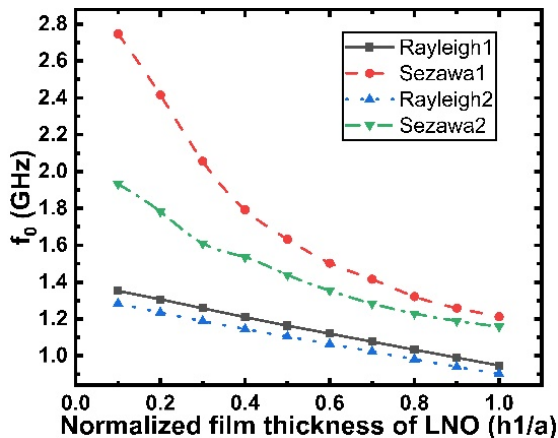
Figure 15. Plot of central frequency versus normalized LiNbO 3 thickness ( h 1 / a ). Rayleigh1, Sezawa1, and Rayleigh2, Sezawa2 are the two SAW modes before and after the layer thickness h 5 / a = 0.1 is added, respectively.